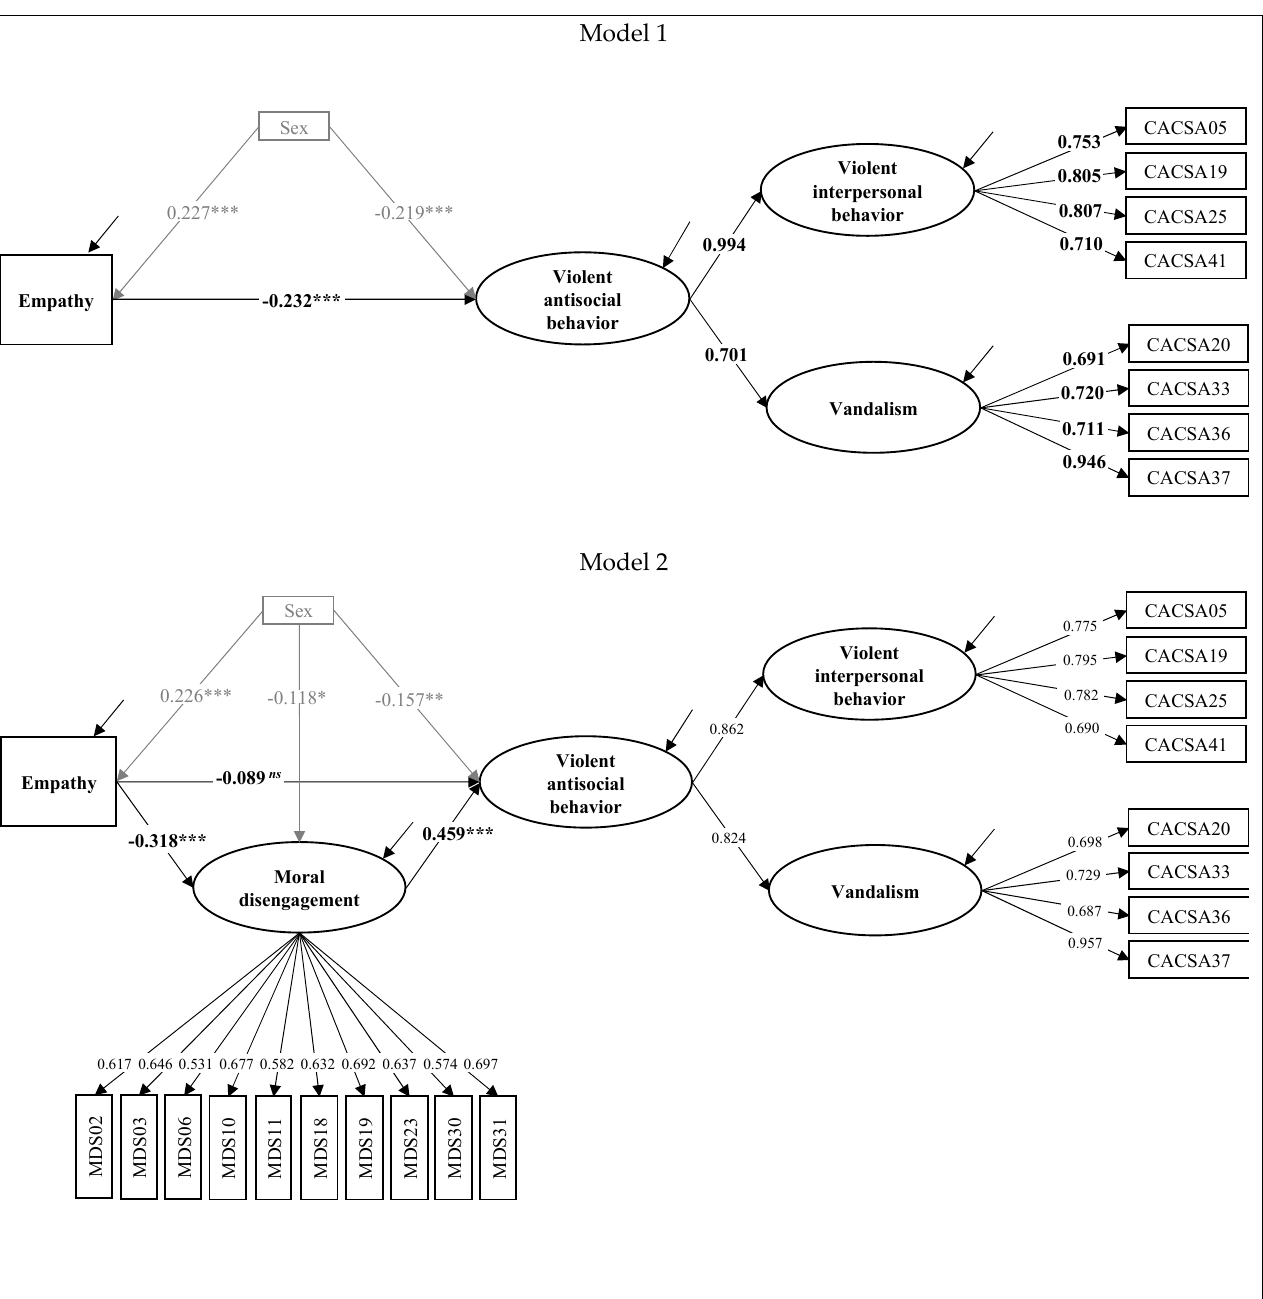
Figure 1. Predictive models of violent antisocial behavior without and with MD as a mediator. Note : Model 1 = predictive model with control variable and without MD as a mediator; model 2 = predictive model with control variable and with MD as a mediator. *** = p < 0.001. ** = p < 0.01. * = p < 0.05. ns = not significant.